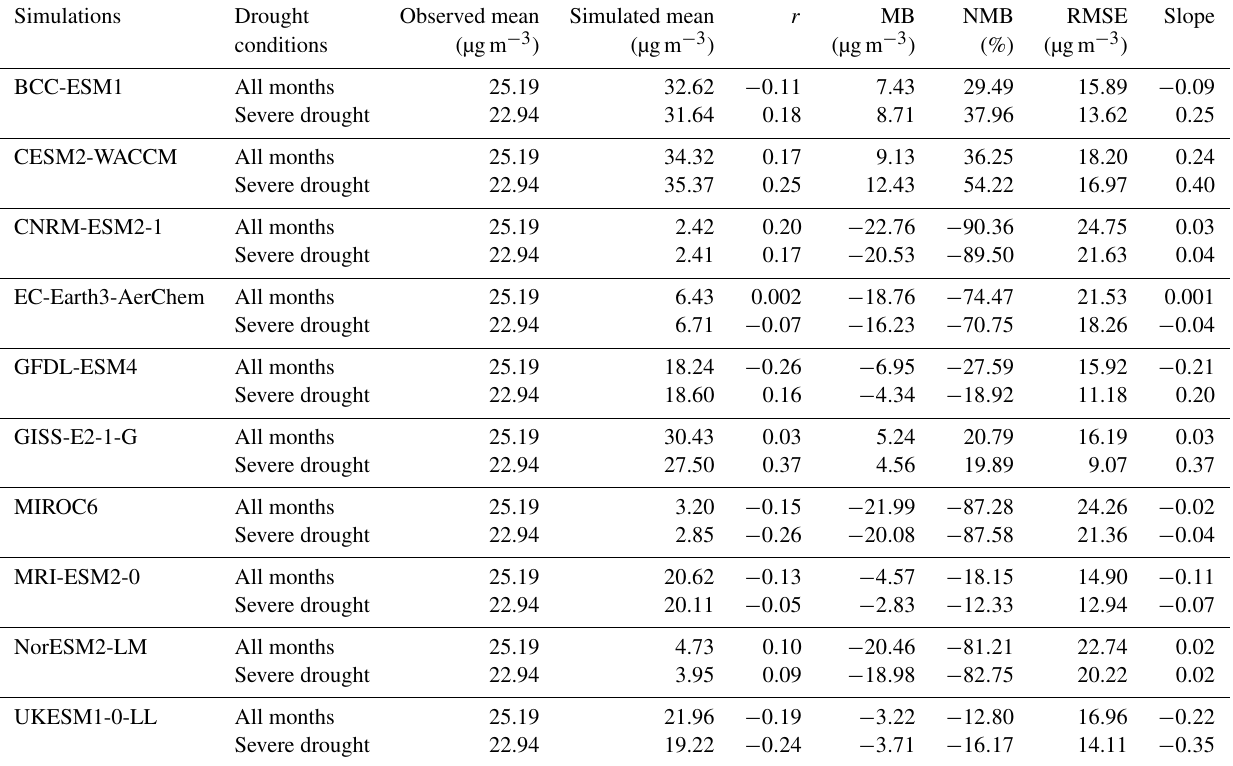
Table 1. Evaluation metrics of 10 CMIP6 models in comparison with observations at the Barbados site during 1973–2014 in JJA. Metrics include the correlation coefficient ( r ), mean bias (MB), normalized mean bias (NMB), root mean square error (RMSE), and slope. Simulations Drought Observed mean